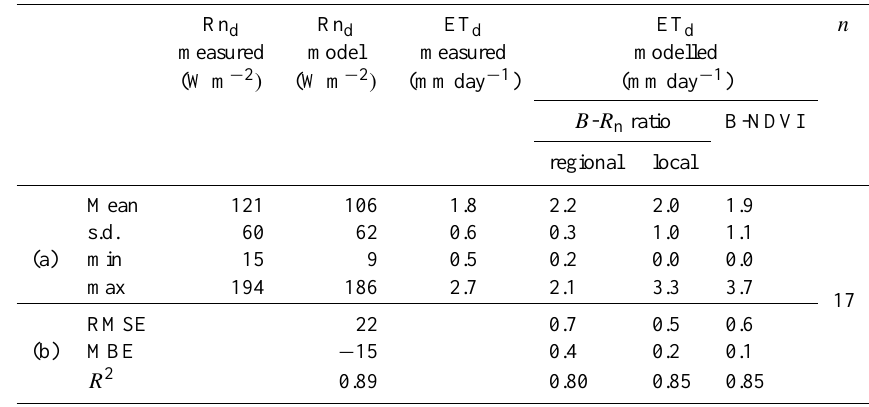
Table 1. (a): Descriptive statistics of daily net radiation (Rn d ) and daily evapotranspiration (ET d ) measured over the Scots pine stand, and Landsat Rn and ET d modelled using 3 methods: B - R n ratio regional, B - R n ratio local and B-NDVI (see text). (b) Model validation results. s.d. is standard deviation, RMSE is root mean square error and MBE is mean bias error.